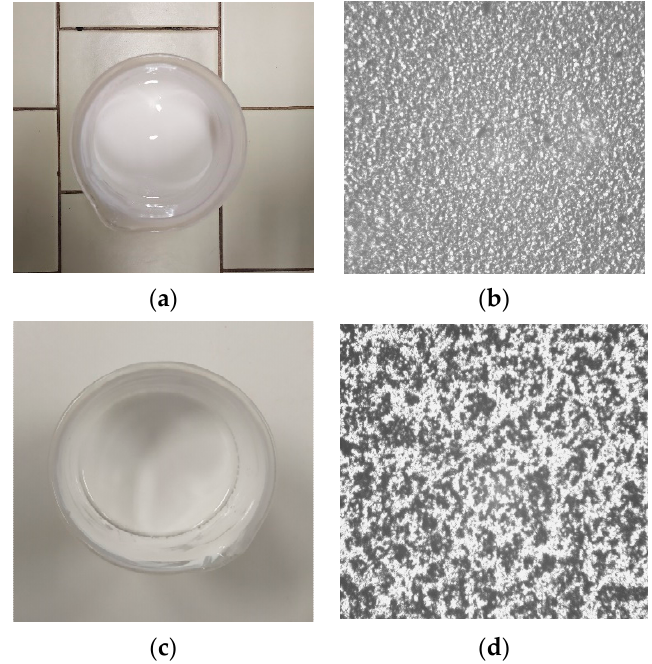
Figure 4. ( a ) 40% TiO 2 in castor oil; ( b ) TiO 2 dispersion in castor oil after 50% dilution (300×); ( c ) 40% TiO 2 in Plantasens Olive LD SP ECO; ( d ) TiO 2 dispersion in Plantasens Olive LD SP ECO after 50% dilution (300×).